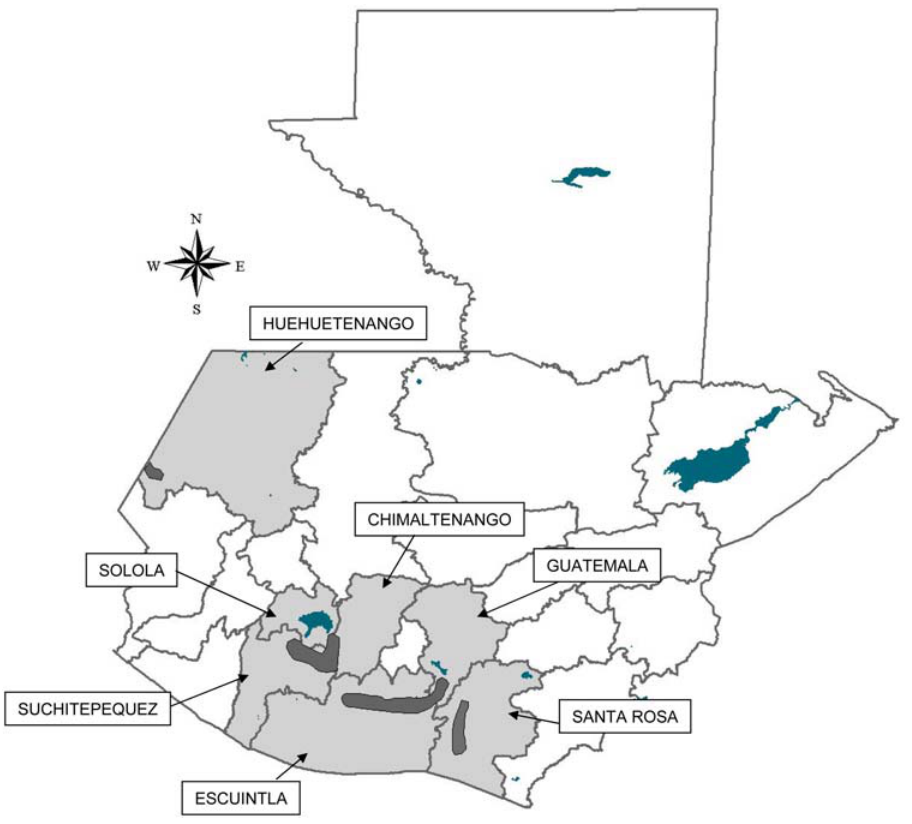
Figure 1. The four onchocerciasis foci in Guatemala (dark gray) in the endemic departments (light gray).